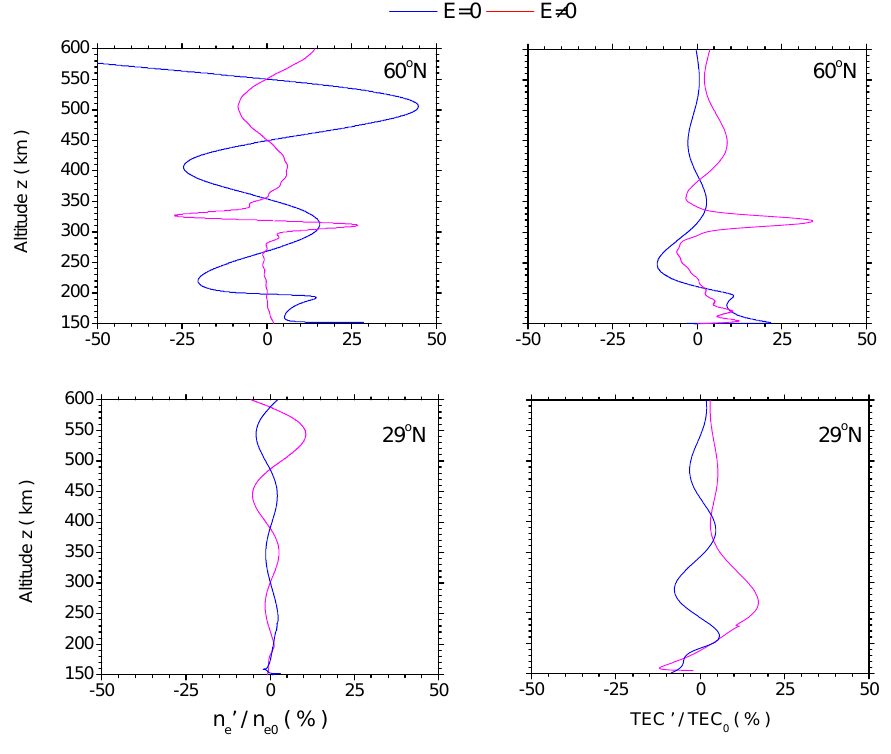
Figure 6. Vertical profiles of electron density and TEC perturbations in the absence (curves in blue) and presence (curves in pink) of the dynamo electric field, E , at middle and low latitudes, 60 ◦ N and 29 ◦ N, respectively. A typical tsunami case of L L ( y ) = 400 km, and α = 0 . 01 , is chosen in reference of Hickey et al. ’s model tsu d